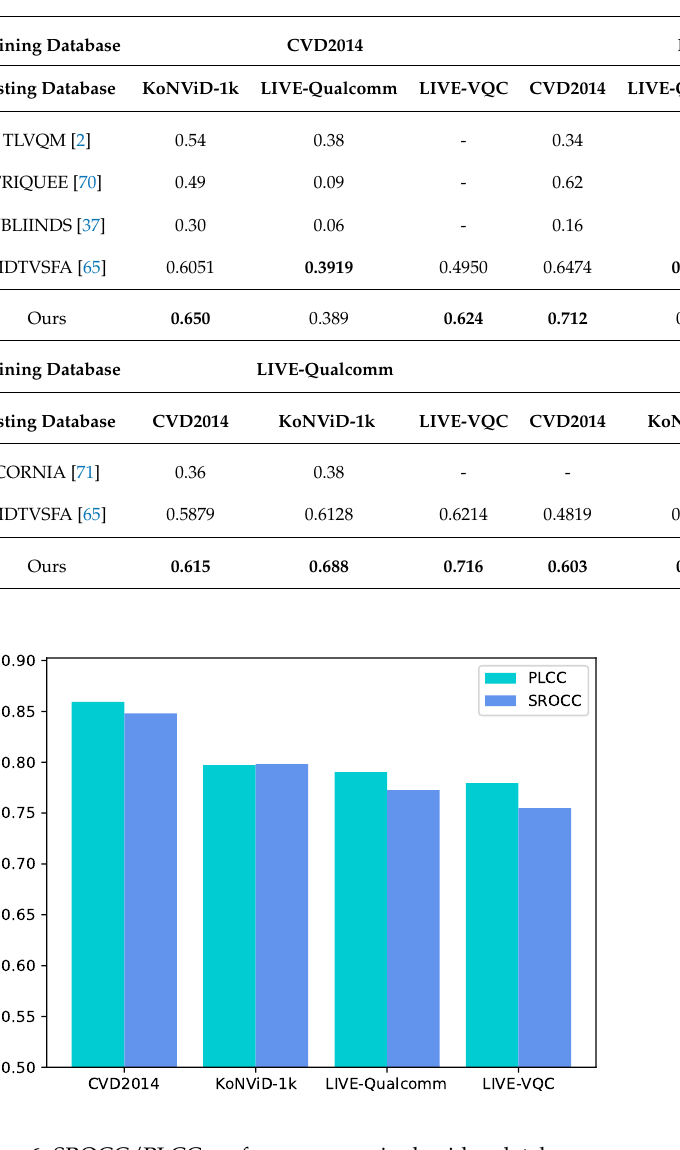
Figure 6. SROCC/PLCC performance on single video